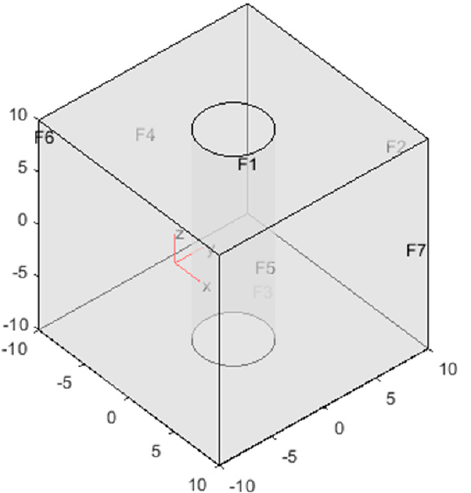
conducted away from the advective heat influx flow structure in order to match observation. Figure 15 results for the Figure 13 wellbore model are to be compared with Figure 10.